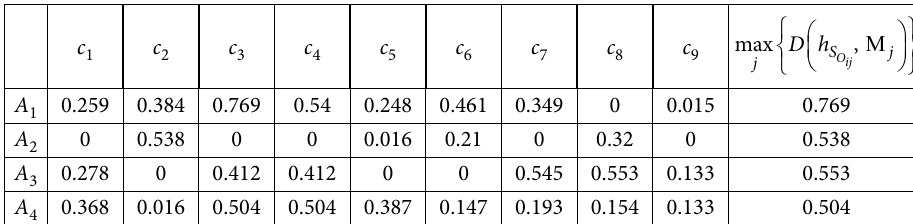
Table 6. The results of the